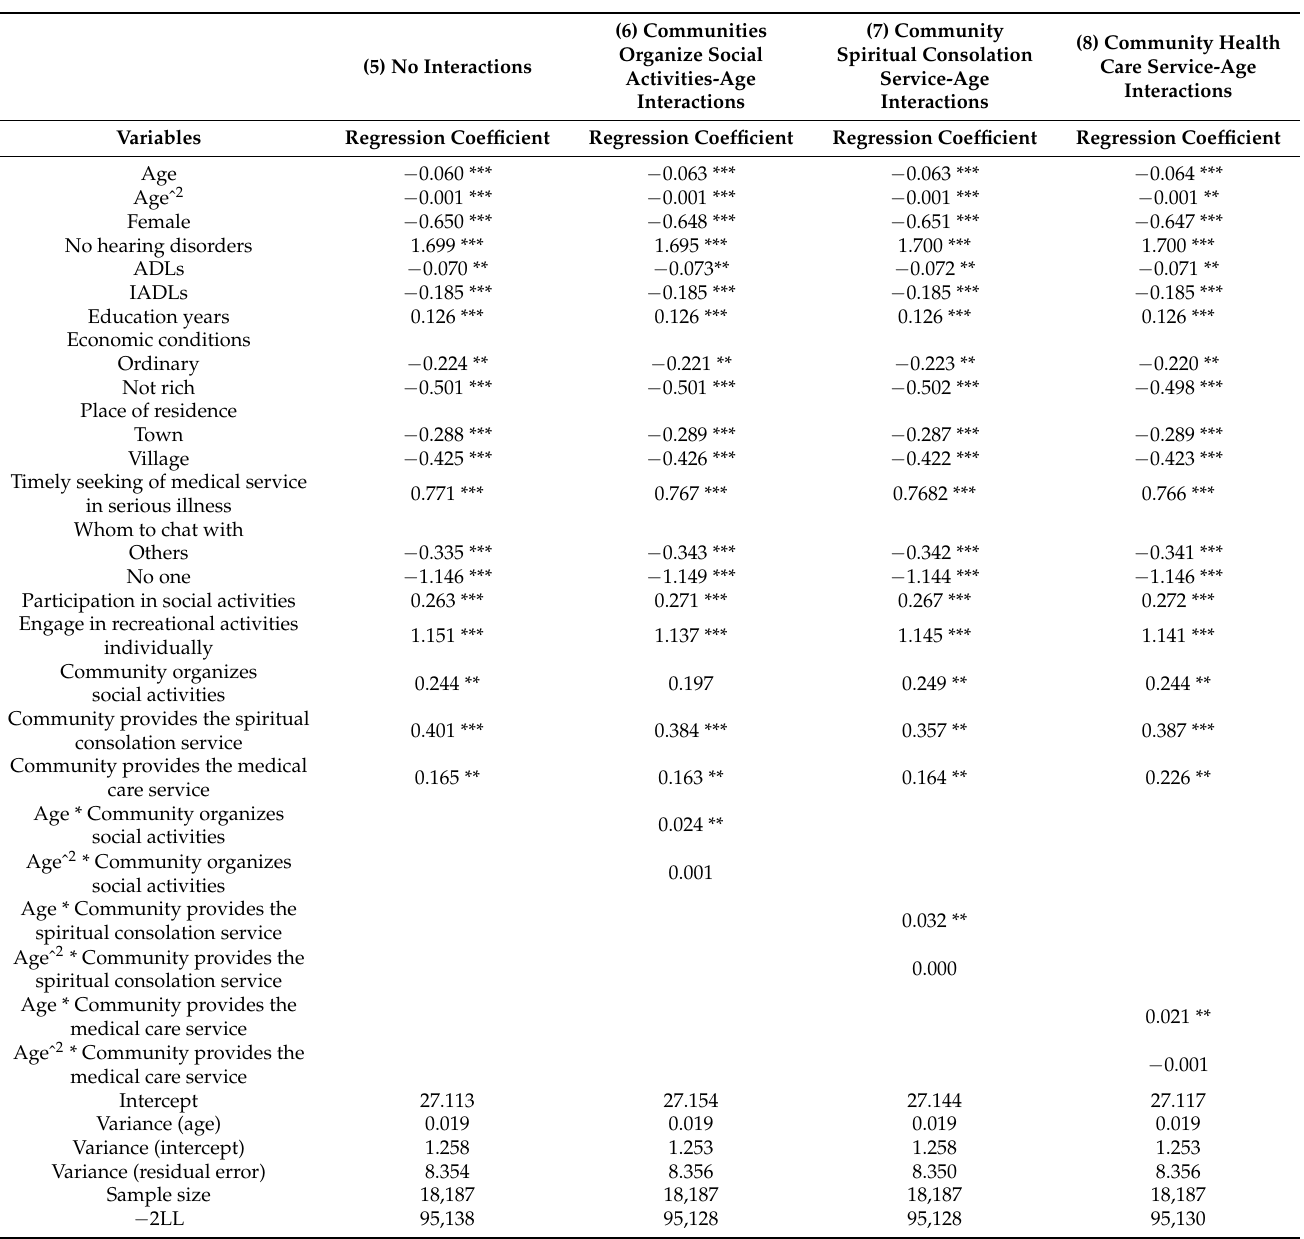
Table 3. Multilevel regression model of changes in cognitive abilities.